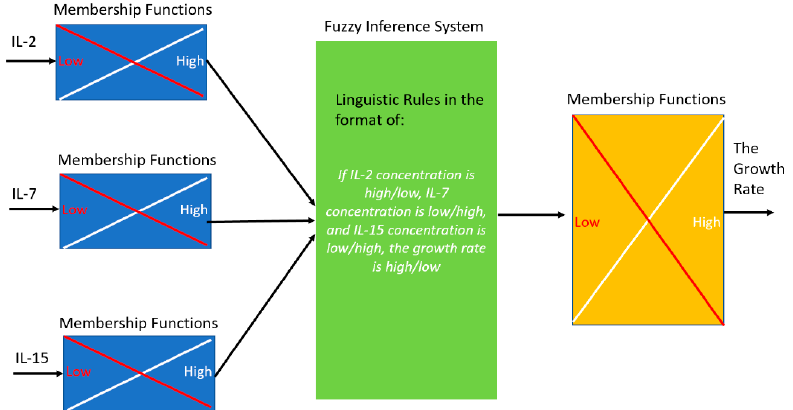
Figure 6. An illustrative diagram of the fuzzy model to link the cytokine concentrations to the T cell growth rate. Membership functions were used to evaluate the possibility of each cytokine to be low or high (i.e., fuzzification), which is followed by the linguistic rules (i.e., inference) to determine the growth rate (i.e., defuzzification).